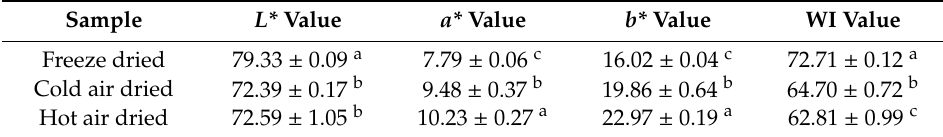
Table 1. Color evaluation of T. fuciformis by various drying